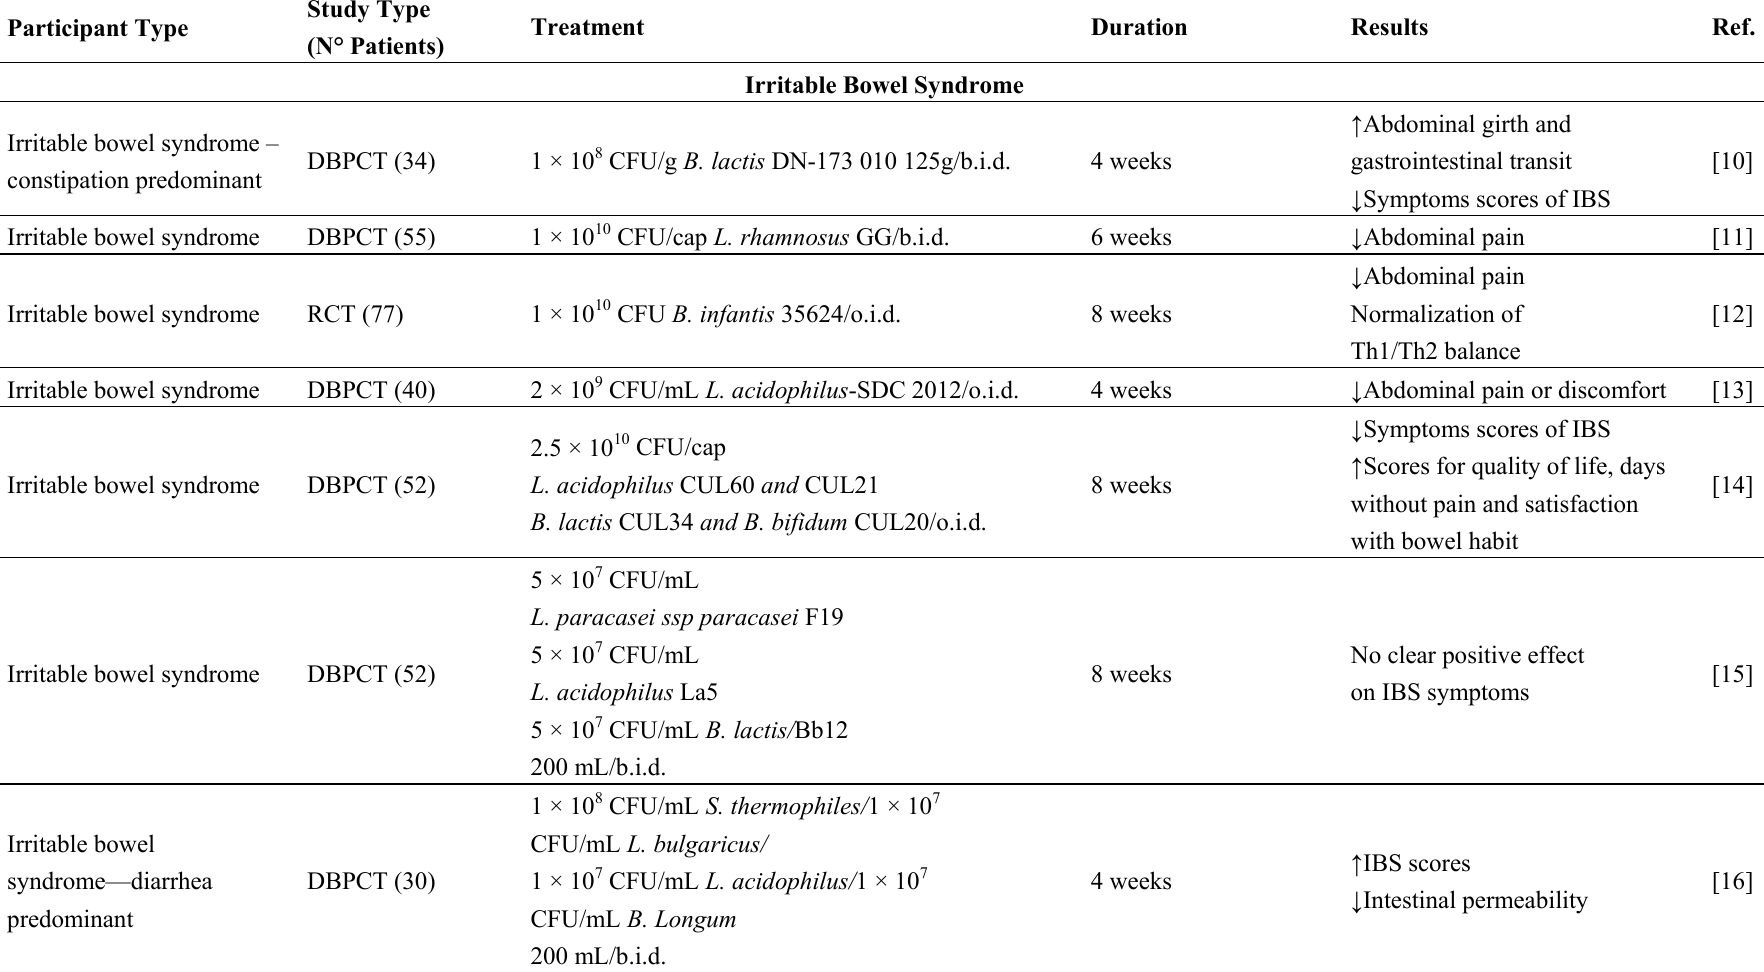
Table 1. Clinical studies of probiotics (with and without prebiotics) and gastrointestinal tract